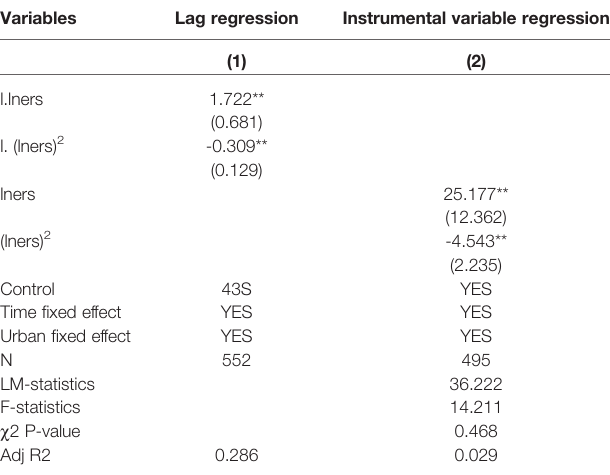
TABLE 4 | Endogenous test.